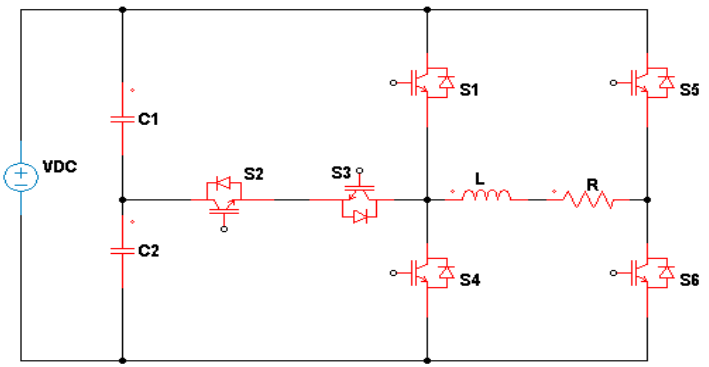
Figure 2. A single-phase T-type five-level inverter.